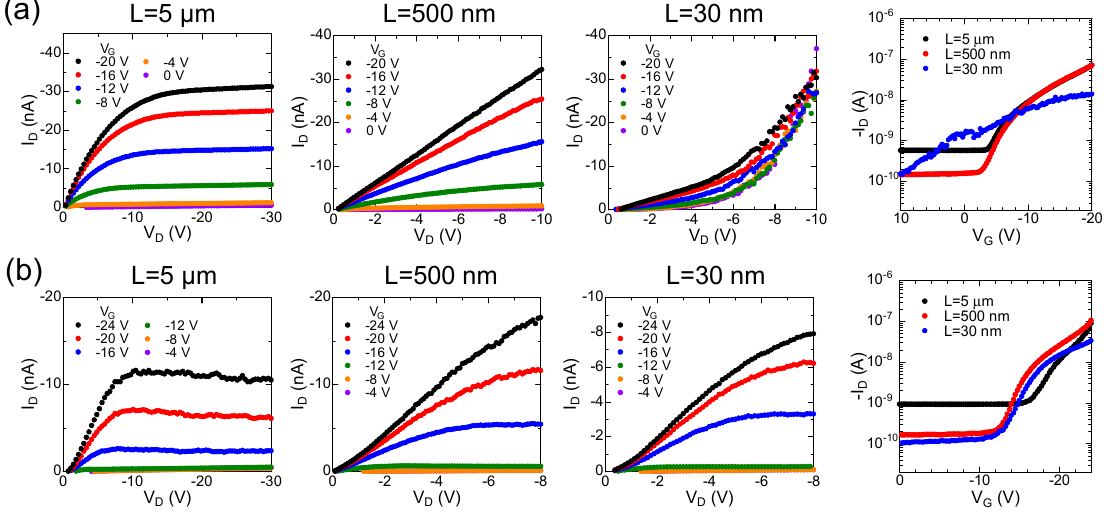
Figure 5. Output and transfer characteristics of ( a ) P3HT FETs and ( b ) F8T2 FETs with L of 5 μ m, 500 nm, and 30 nm on 50-nm-thick SiO 2 insulators treated with PETS.